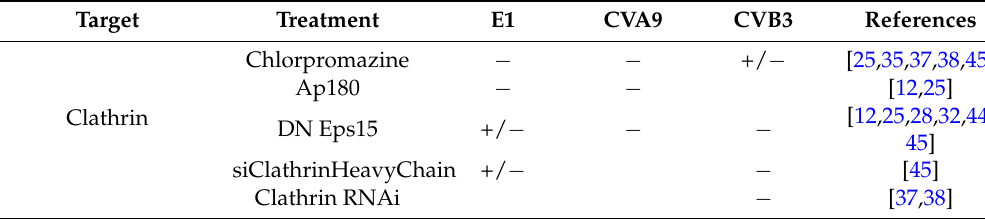
Table 1. Different treatments and their effect on E1, CVA9 and CVB3